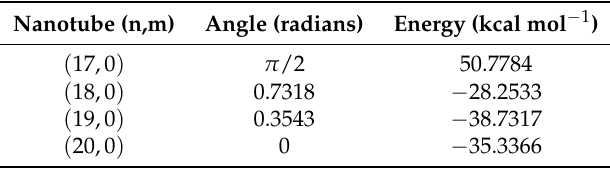
Table 3. Optimal tilt angles and corresponding potential energies for single coronene molecule within carbon nanotube of specified